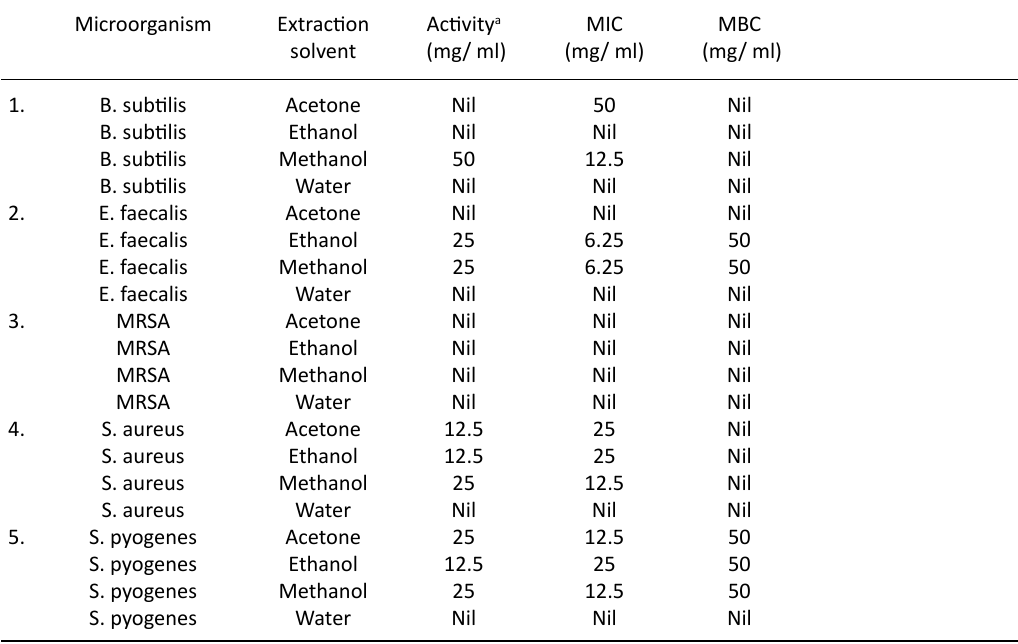
Table 1. Antibacterial activity, minimum inhibitory concentration (MIC) and minimum bactericidal concentration of acetone, ethanol, methanol and water extracts of C. persicum tubers on different pathogenic Gram positive